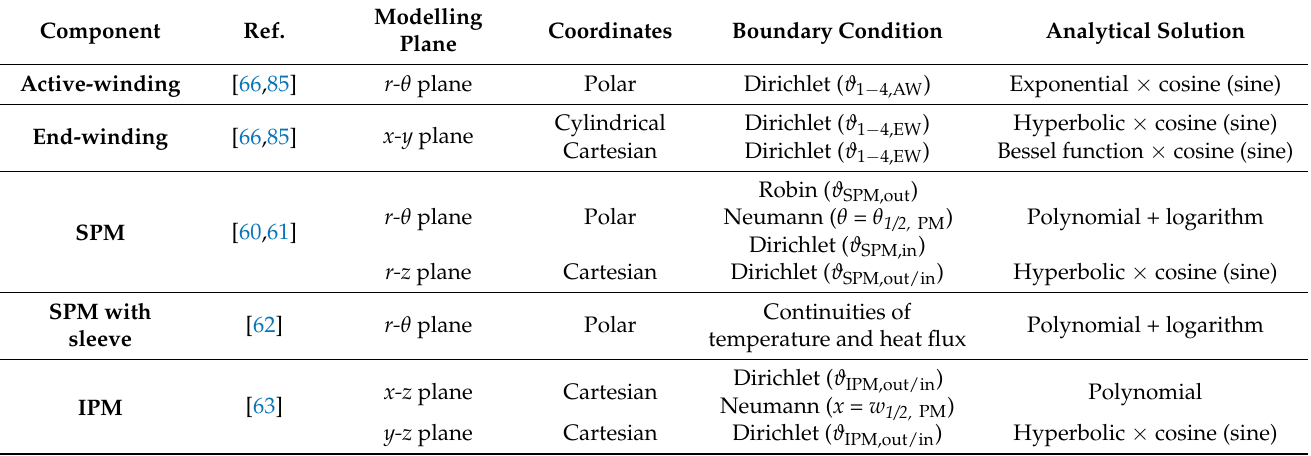
Table 7. Summary of analytical thermal modelling for windings and